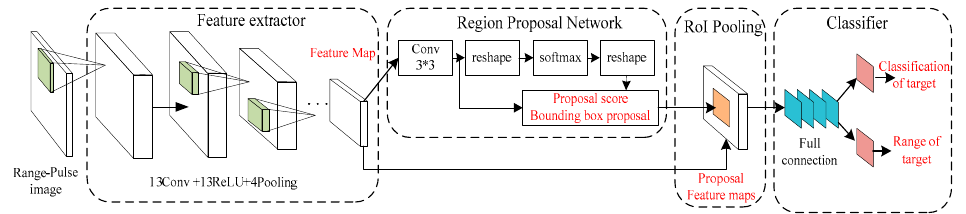
Figure 13. Faster R-CNN-based model for RTD with Pulse-Range Figure 13. Faster R ‐ CNN ‐ based model for RTD with Pulse ‐ Range images.